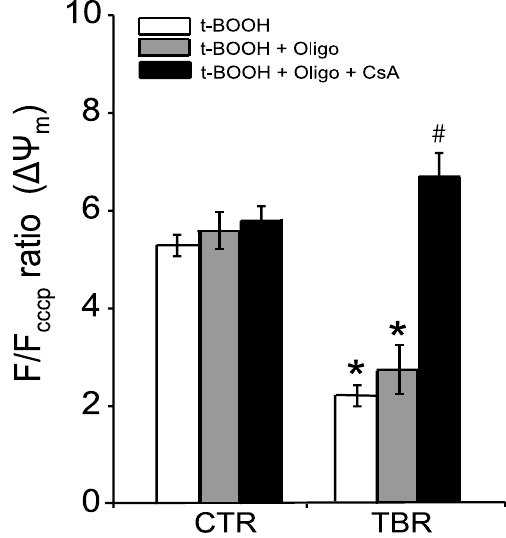
Fig. 7 – Mitochondrial permeability transition mediates t-BOOH-induced (cid:1)(cid:2) m decrease in TBR lymphocytes. (cid:1)(cid:2) m in CTR and TBR lympho- cytes (10 6 cells/ml) was determined after 4 h incubation in the presence of 500 µ M t-BOOH. Where indicated, 1 µ M oligomycin (Oligo) and/or 1 µ M cyclosporin A (CsA) were added to the incubation medium. (cid:1)(cid:2) m was determined as the ratio of DioC 6 (3) fluorescence (F) in the absence of 50 µ M CCCP to that in its presence (F/F CCCP ). *p < 0 . 05 vs. respective CTR group; # p < 0 . 05 vs. lymphocytes treated only with oligomycin.